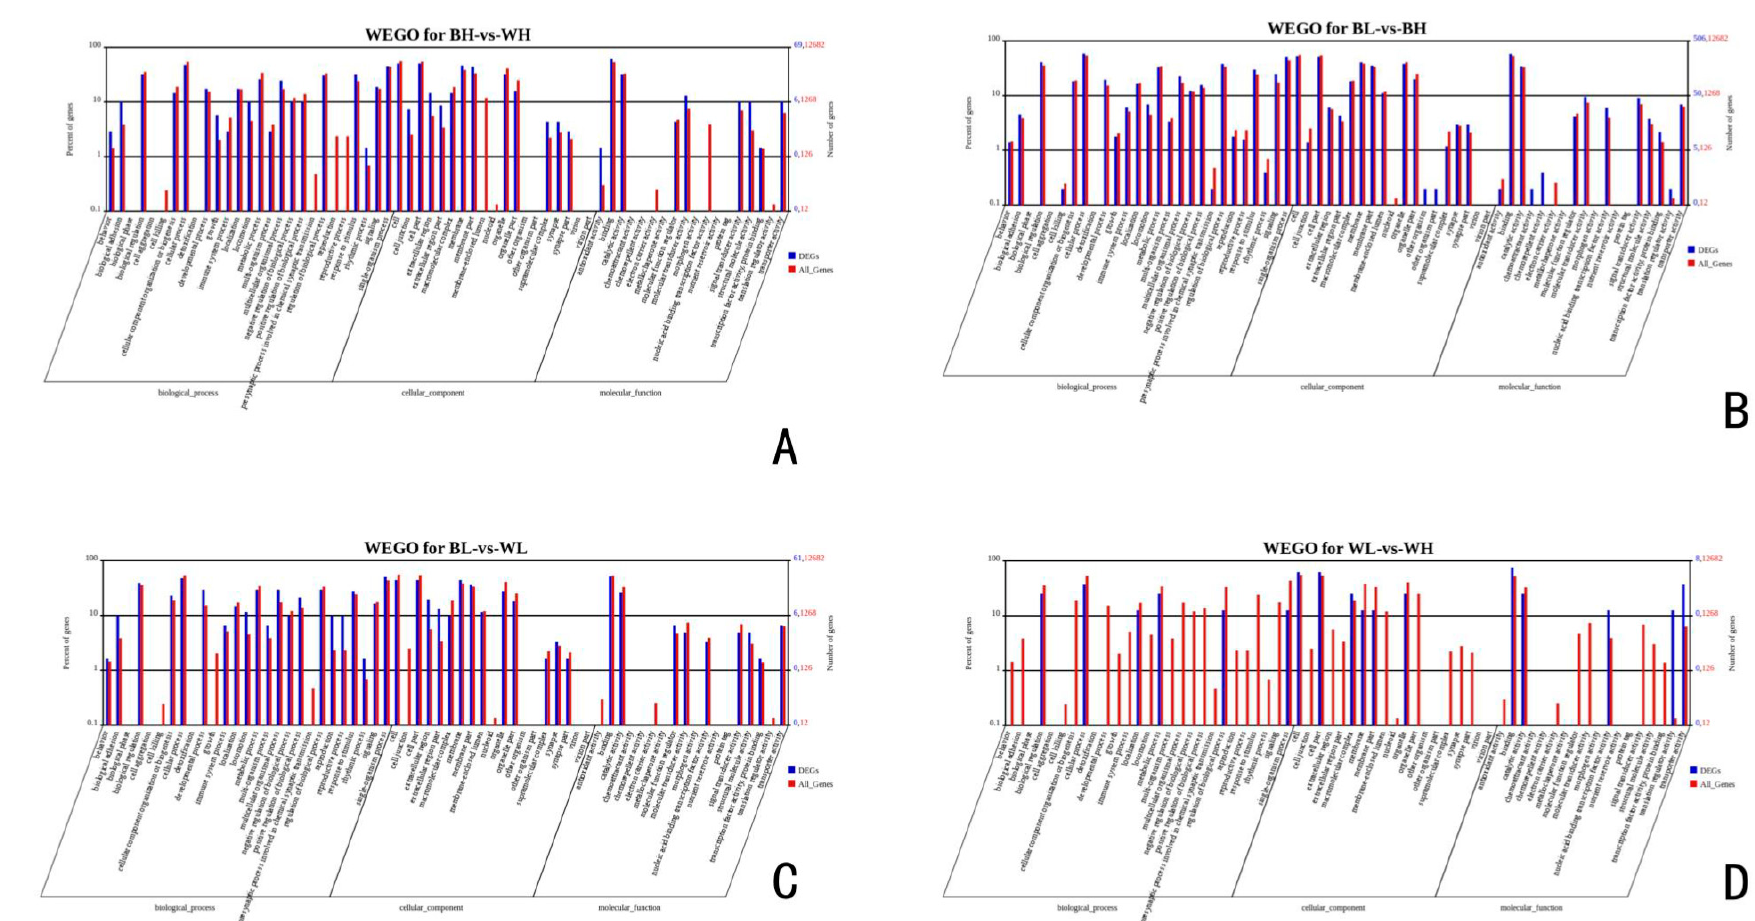
Figure 4. Gene Ontology (GO) terms for DEGs in ( A ) BH-vs-WH, ( B ) BL-vs-BH, ( C ) BL-vs-WL and ( D ) WL-vs-WH.